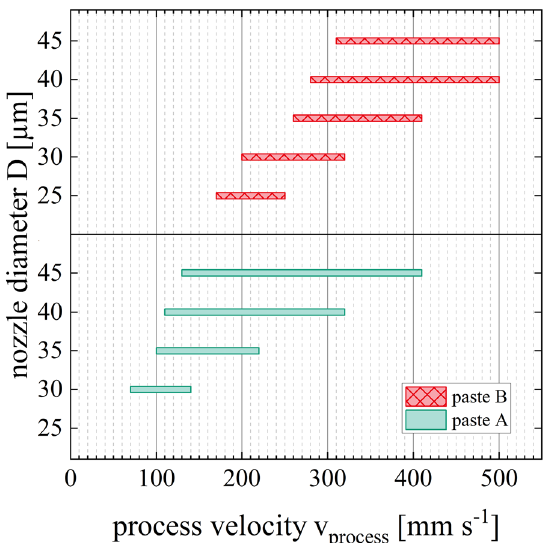
Figure 7. Process velocity ranges of category II for pastes A and B are presented for nozzle openings between D = 45 µm and D = 25 µm. The process velocity range is limited by the minimum process velocity v process,min and the maximum process velocity v process,max